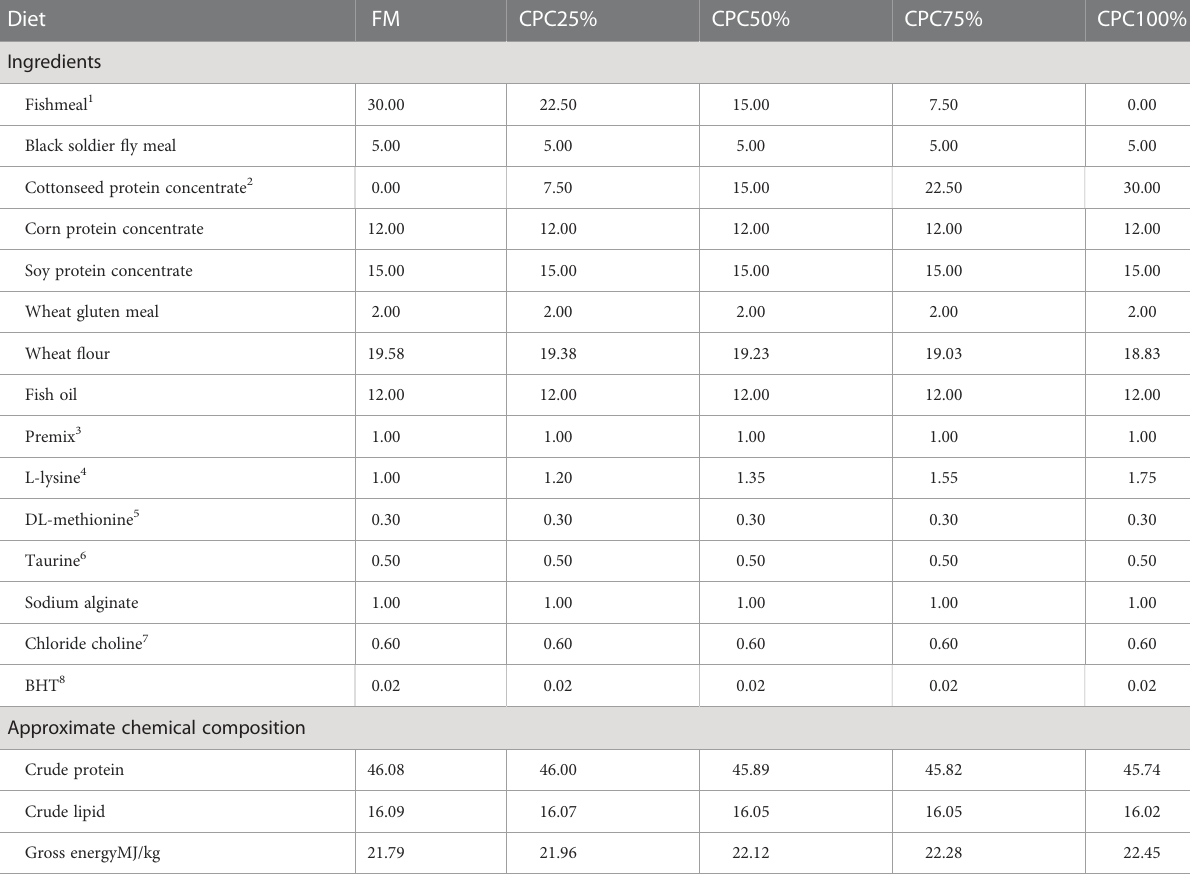
TABLE 1 Formulation and chemical composition of the experimental diets (% dry matter). Diet FM